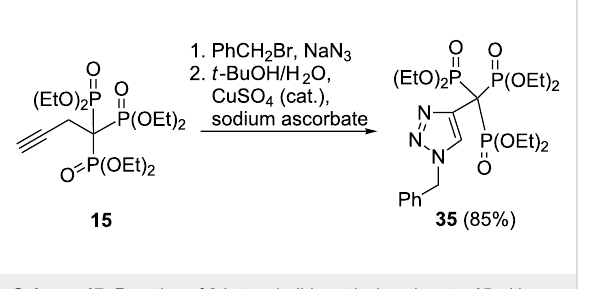
Scheme 17: Reaction of 3-butyn-1-ylidenetrisphosphonate 15 with benzyl